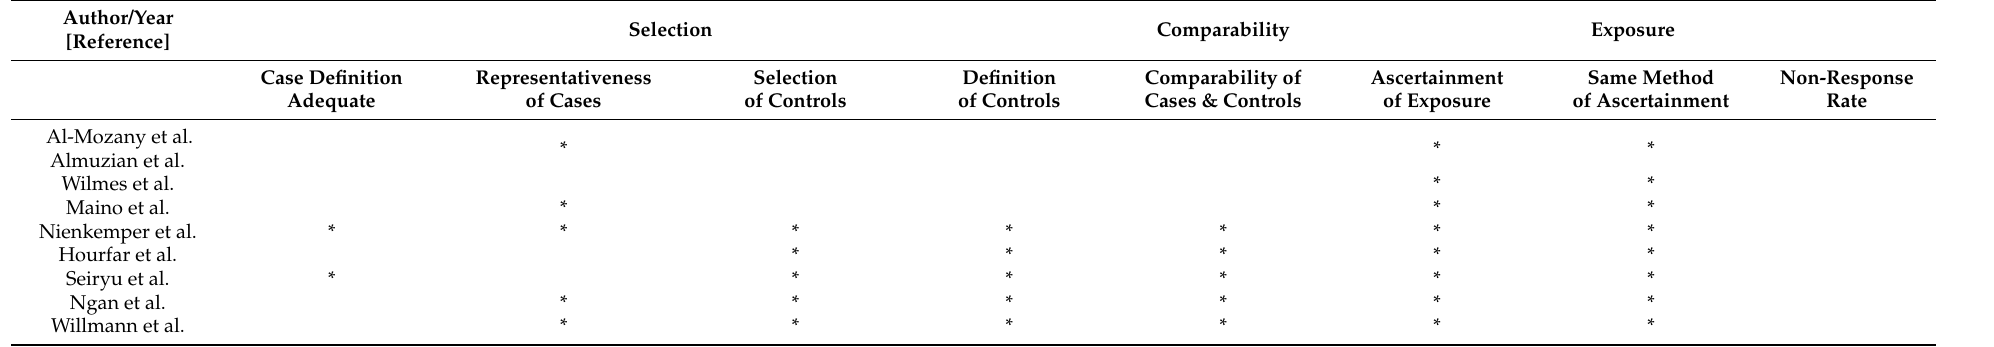
Table 1. Studies’ quality according to the Newcastle–Ottawa Scale.